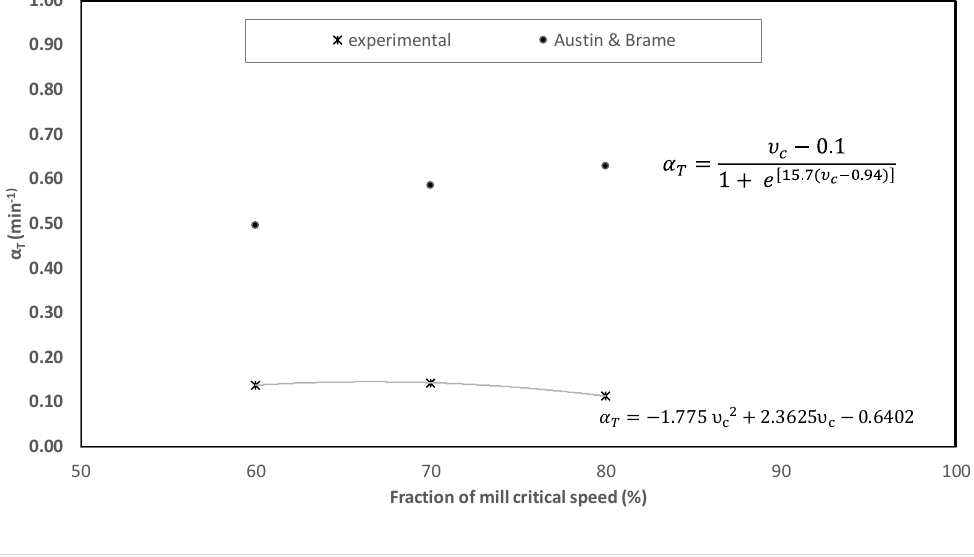
Figure 3. Variation of α T with the working speed fraction.